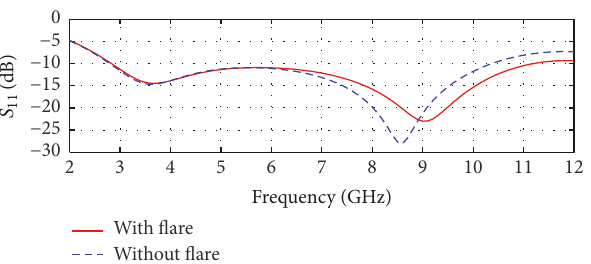
Figure 4: Effect of flaring structure on impedance bandwidth.